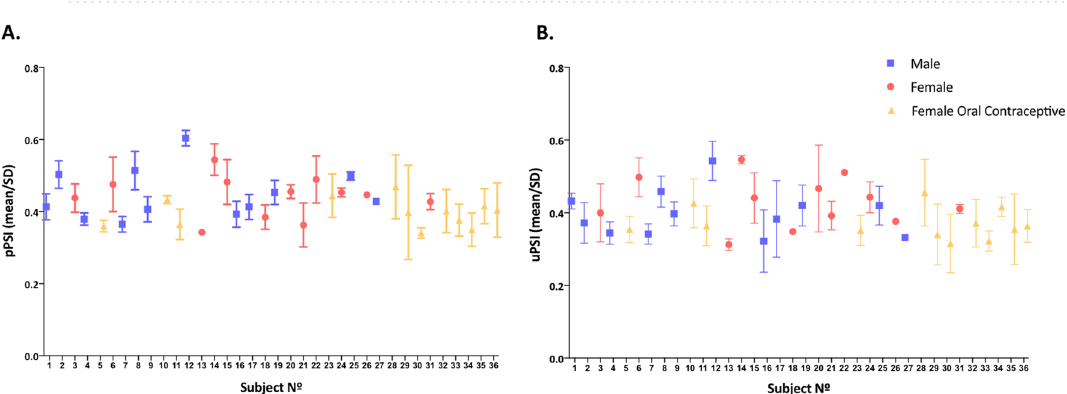
Figure 2. Frequency histogram plotted as Paracetamol Sulfonation Index (PSI) for clinical phenotyping of SULT vs. number of individuals (n = 36). Abscissa denotes the metabolic ratio expressed as PSI, calculated from unchanged paracetamol and its sulfate and glucuronate conjugates, measured in plasma (A) and urine (B) samples using LC-HRMS, 2 h after ingestion of 1 g of paracetamol. We found a similar distribution of PSI for plasma (A) and urine (B) samples, revealing an identical mean and a right skew. Although the distribution is mostly uniform, individuals with higher sulfonation capacity may be singled out.